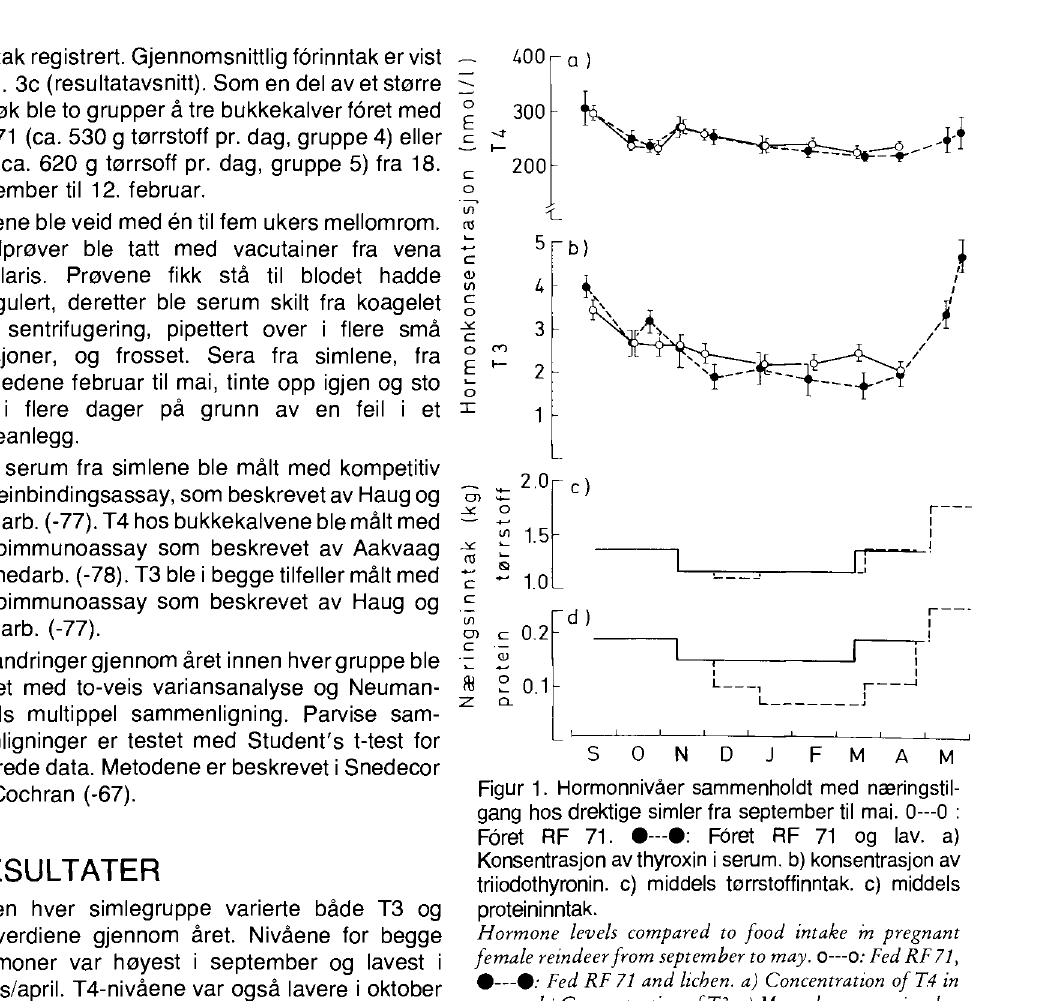
Figur 1. Hormonnivåer sammenholdt med næringstil gang hos drektige simler fra september til mai. 0—0